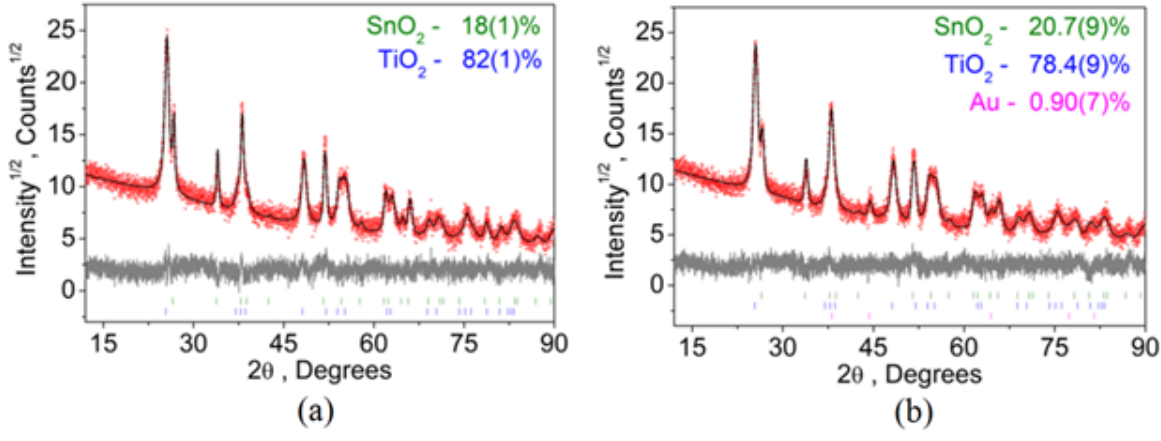
Figure 3. XRD pattern of ( a ) TiO 2 /FTO/glass and ( b ) Au/TiO 2 /FTO/glass photoelectrodes.